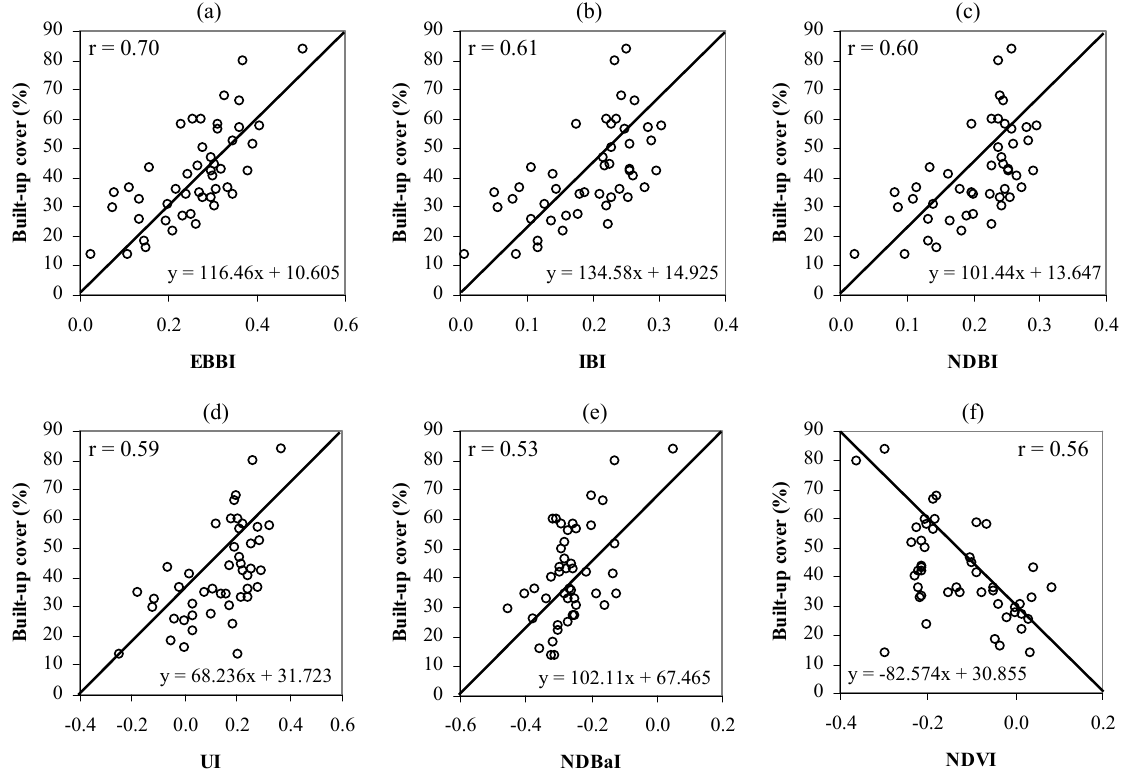
Figure 4. Scatterplots of the built-up area percentage vs. the remote sensing transformation indices. ( a ) EBBI, ( b ) IBI, ( c ) NDBI, ( d ) UI, ( e ) NDBaI, and ( f ) Normalised Difference Vegetation Index (NDVI) .